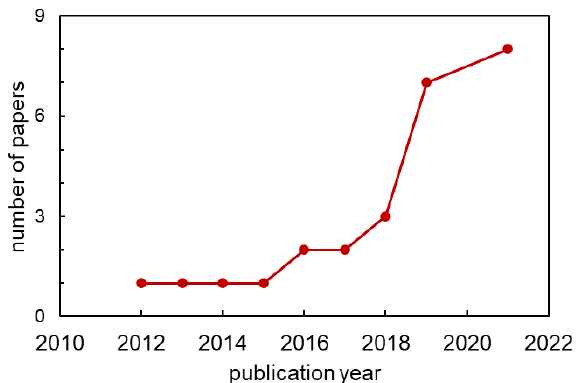
Figure 1. The evolution of the number of published papers reporting studies on CO 2 hydrogenation catalyzed by graphene-based materials.